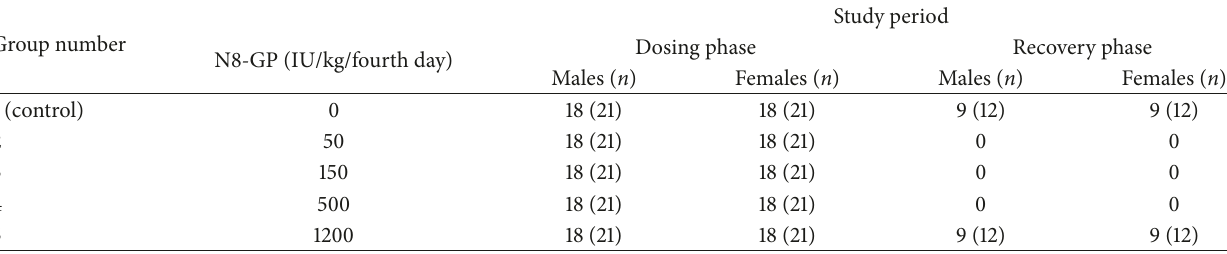
Table 1: Design and doses of the 26- and 52-week